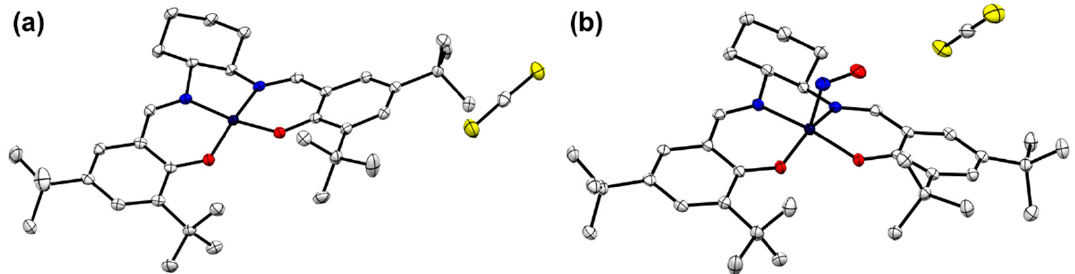
Figure 4. Single crystal X-ray structures of ( a ) Co(L R,R ) · CS 2 , and ( b ) Co(NO)(L R,R ) · CS 2 . Atom colors: red—oxygen; blue—